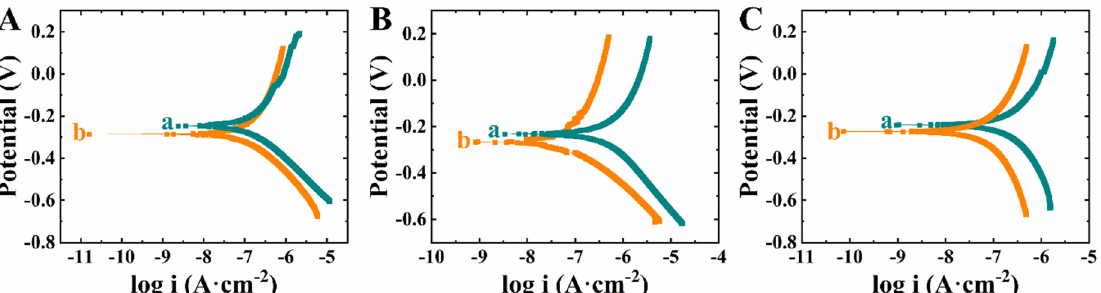
Figure 7. Tafel plots for as-deposited (a) monolayer PEMA-FRM coatings and (b) bi-layer composite coatings containing annealed PEMA bottom layer and PEMA-FRM top layer with ( A ) huntite, ( B ) halloysite, and ( C ) hydrotalcite.